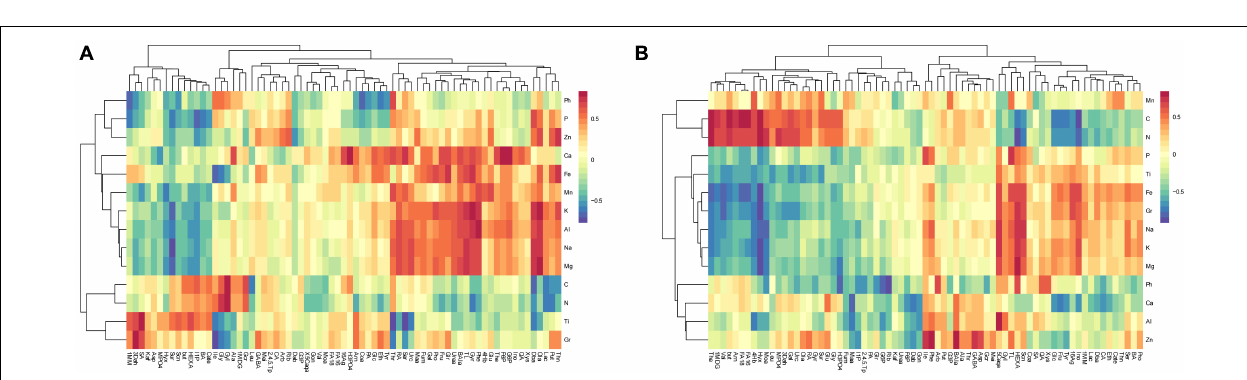
FIGURE 6 | The heat maps of the correlation between soil mineral elements and needle metabolites in CK groups (A) and OTC groups (B) . Horizontal axis indicates the needle metabolites with significant changes under warming conditions; vertical axis indicates the needle mineral elements with significant changes warming conditions. Abbreviations were listed in Supplementary Table 1